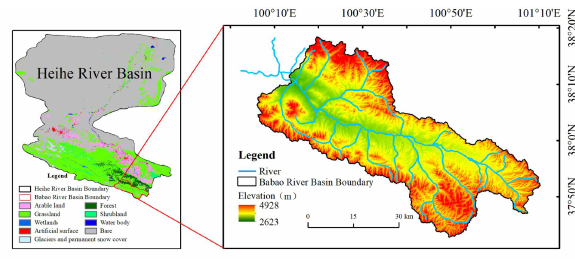
Figure 1. Overview of the study area.